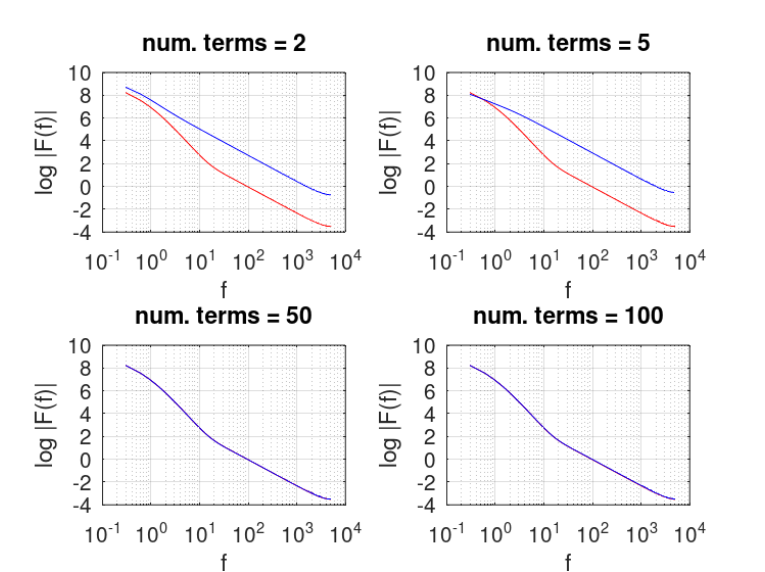
Figure 3. Numerical computation of the FT, F = F [ f ( t )] for the approximate functions depicted in Figure